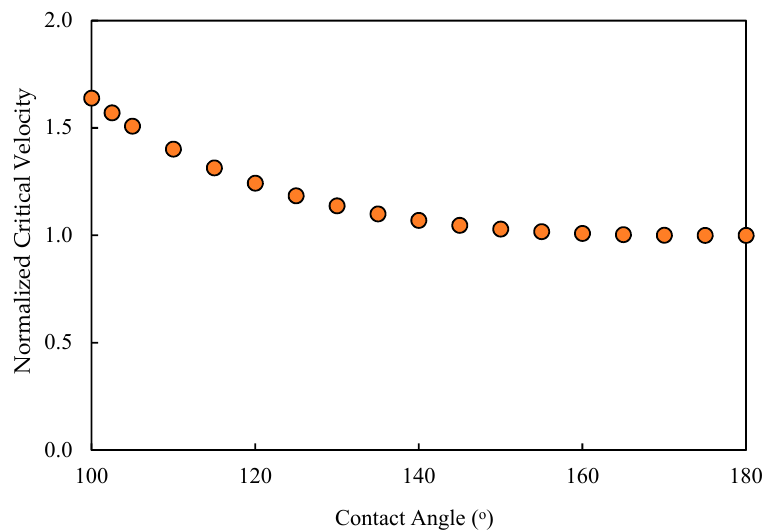
Figure 8. Normalized critical velocity of dislodgment variations as a function of the contact angle. This figure shows that the critical velocity of dislodgment decreases with the increase in the contact angle, which was assumed to be the same at the surface of the membrane and inside the pore. The critical velocity was normalized relative to the critical velocity when the contact angle is 180°.